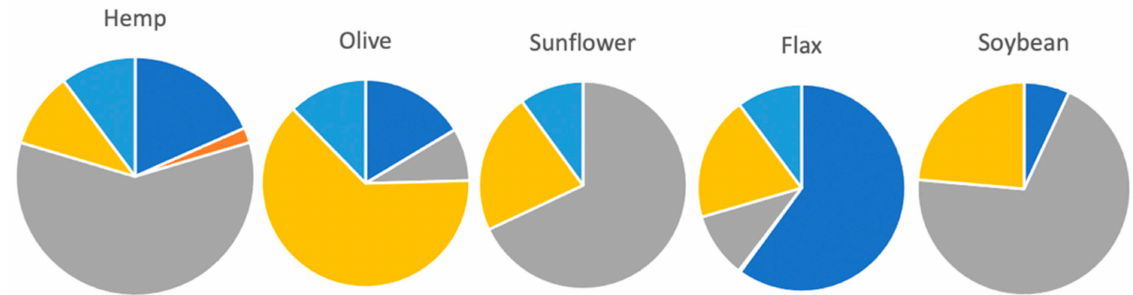
Figure 7. Comparison of the fatty acid composition of edible plant oils